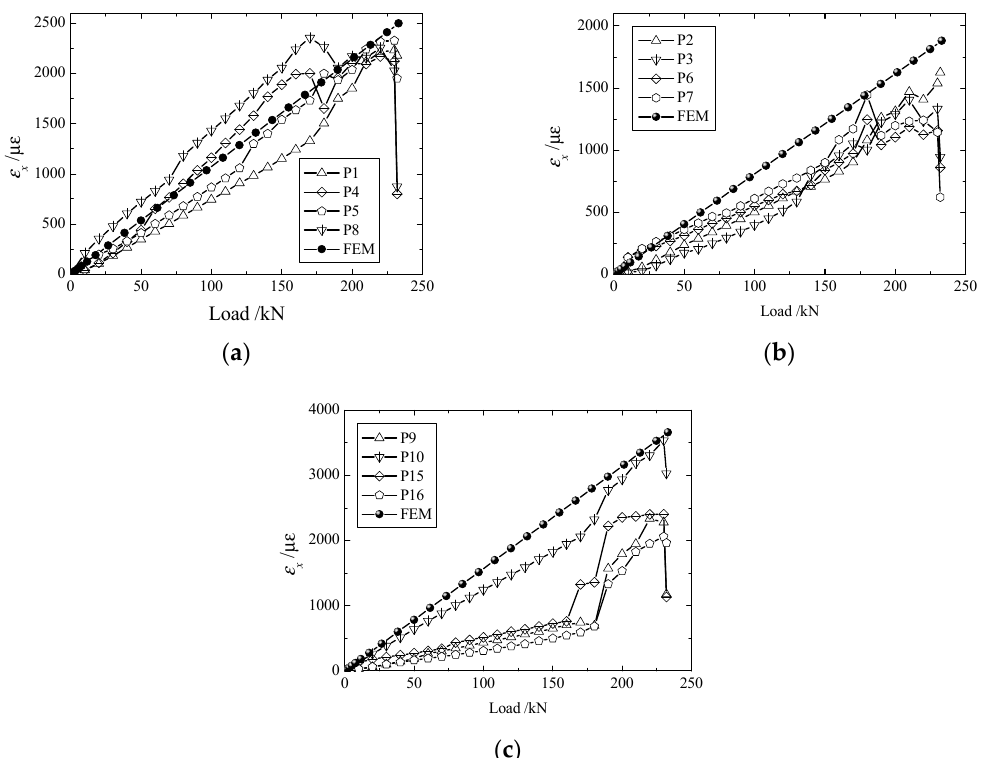
Figure 5. Load-strain curve of ( a ) P1, P4, P5, and P8; ( b ) P2, P3, P6, and P7, and ( c ) P9, P10, P15 and P16.